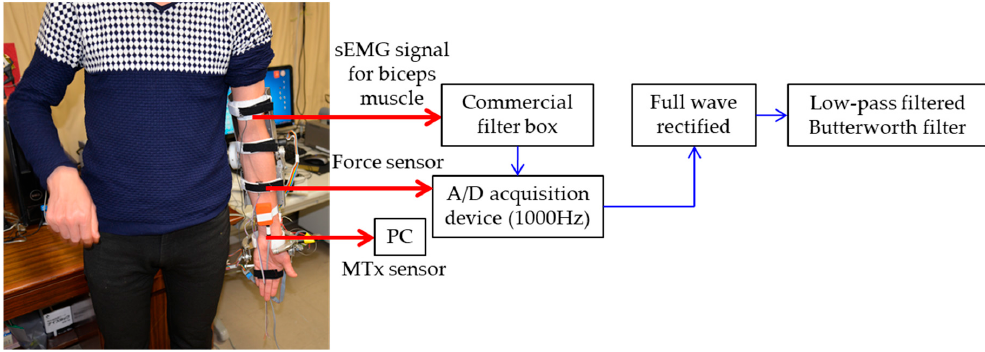
Figure 5. Data acquisition and data processing.